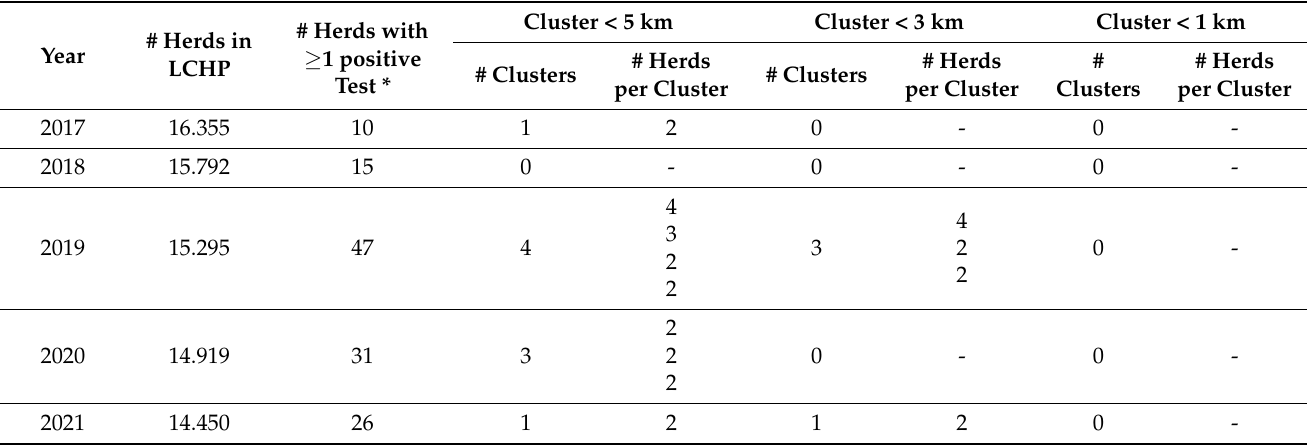
Table 1. Results of cluster evaluation of dairy herds participating in the L. Hardjo control programme. Clusters were classified according to the year in which the first positive sample occurred in the cluster.